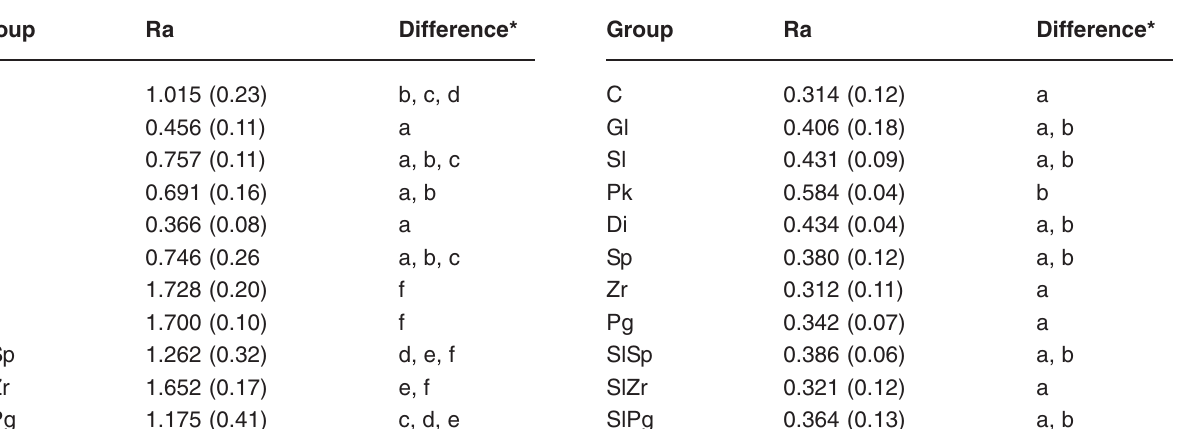
*Different letters indicate statistically significant difference between the groups (p<0.05).